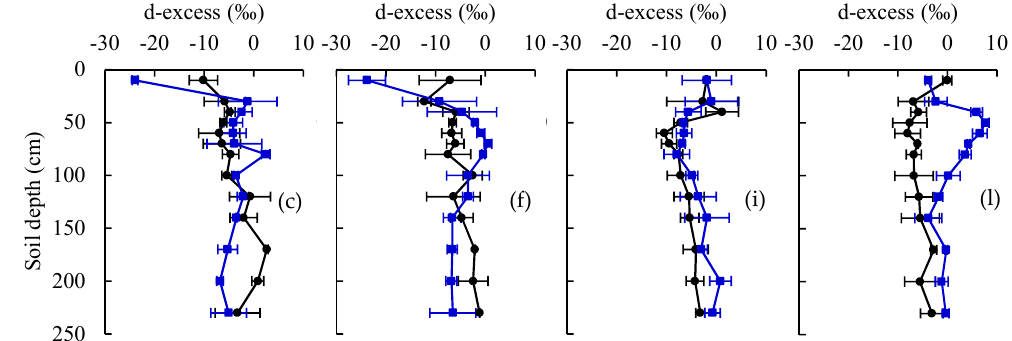
Figure 3 . Depth distribution of δ 2 H, δ 18 O, and deuterium excess (d-excess) at seedling ( a – c ), jointing ( d – f ), tasseling ( g – i ), and filling ( j – l ) growth stages of maize under current and eCO 2 treatments, respectively.